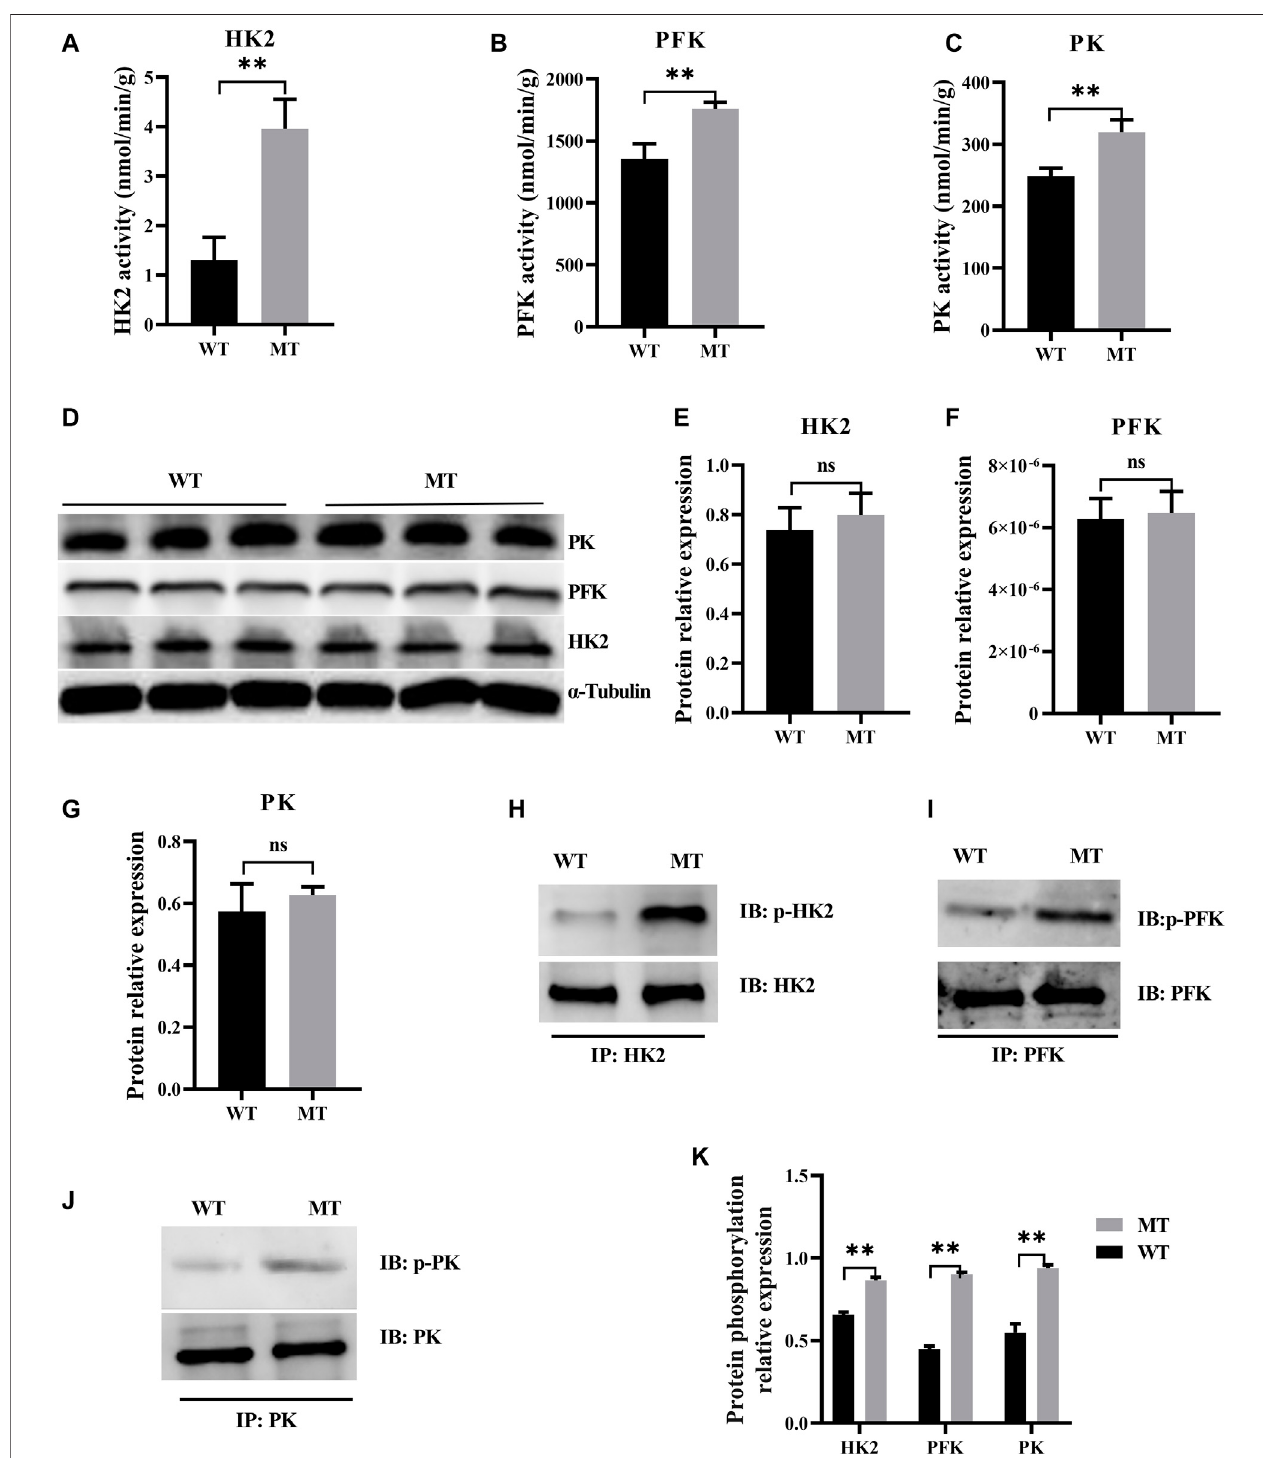
FIGURE 3 | Myostatin mutation mutant effect on heart glycolysis of cattle. (A – C) Activity for key enzymes involved in glycolysis pathway. (D – G) Expression of protein for key enzymes involved in glycolysis pathway in MT and WT cattle heart. (H – K) Expression of phosphorylation of protein for key enzyme protein involved in glycolysis pathway by immunoprecipitation in MT and WT cattle heart. Western blots obtained by immunoblotting antibodies directed against HK2, PFK, PK, and phosphorylation. Abbreviations: PFK, phosphofructokinase; HK2, hexokinase; PK, pyruvate kinase. All data are presented as mean ± SD. Compared with the WT group, * p < 0.05, ** p < 0.01, ns: no signi fi cant; t -tests were used to calculate the p -values.